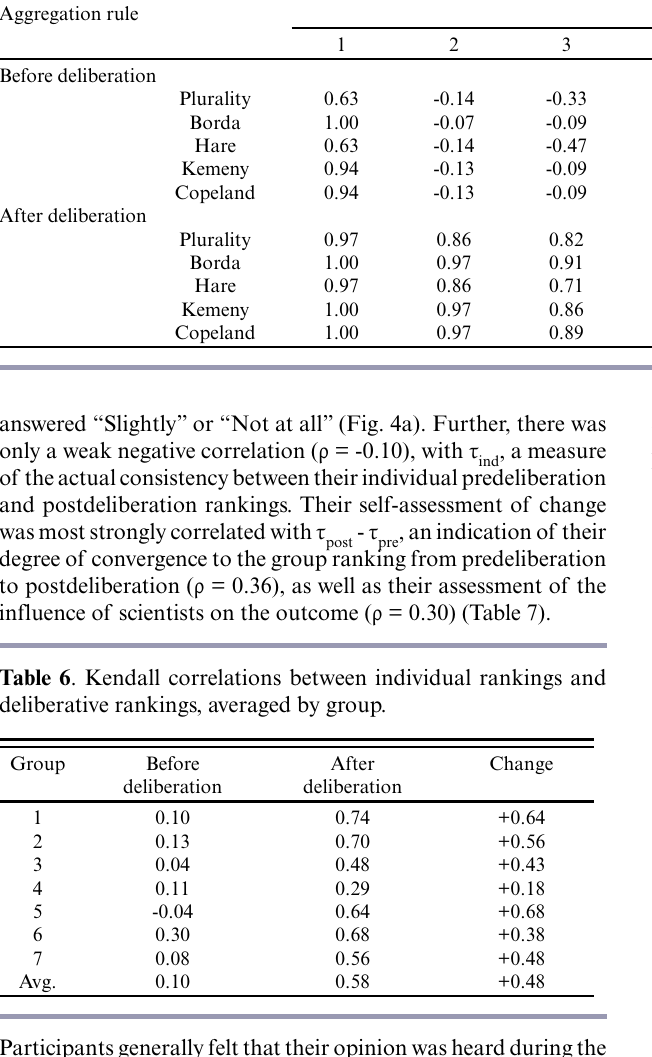
Table 5 . Kendall correlations between aggregated individual rankings and deliberative rankings for each group. Aggregation rule